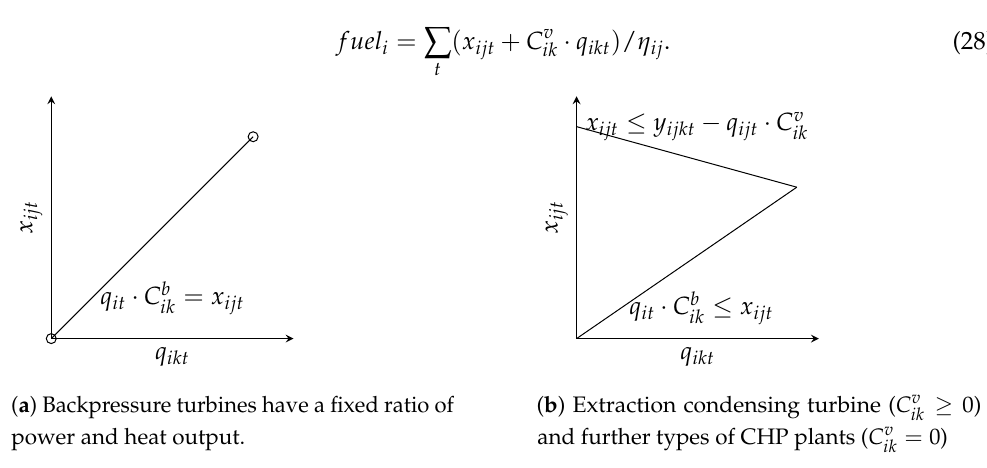
Figure 1. Different types of heat extraction require different models. Heat output is restricted by q it (heat), x it (electricity) ≥ 0 and technology-dependent constraints. Power and heat output are independent, but limit each